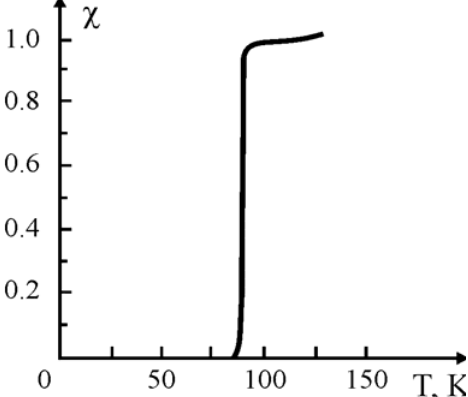
Figure 1. SC transition for the Y weight ratio: 80:20, pressing temperature: 200 ° C